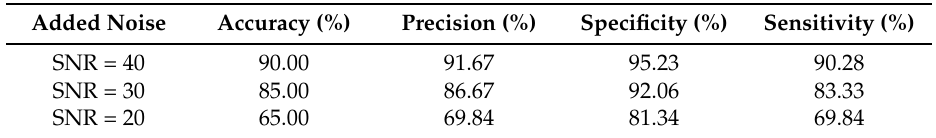
Table 6. The comparisons of optimum statistical parameters of proposed technique with respect to their noisy